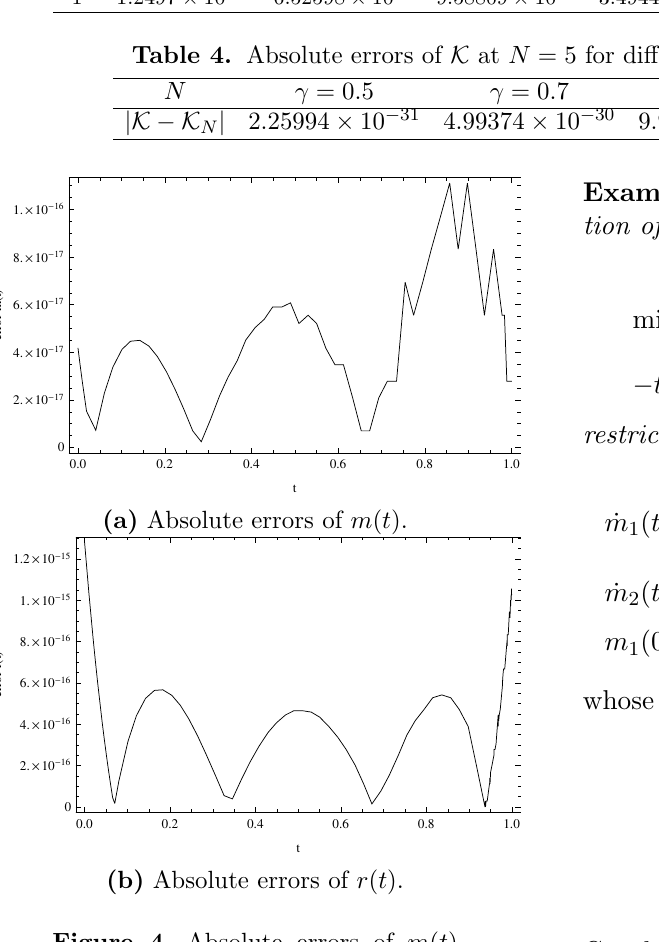
Figure 4. Absolute errors of m ( t ) and r ( t ) for N = 5 and γ = 1 for Example 2.